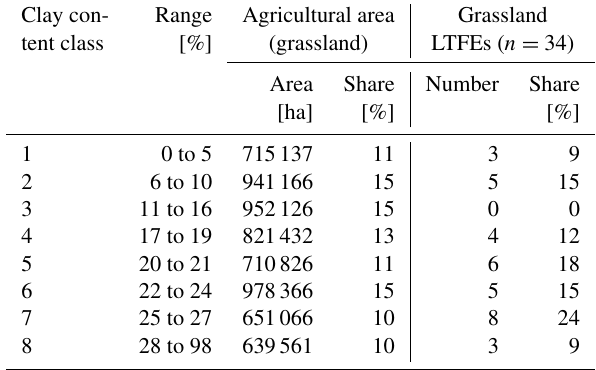
Table 6. Clay content classification according to ESDAC (2020) of agricultural area used for grassland in Germany and the number and share of the LTFEs on grassland in each clay content class. Clay con- Range Agricultural area